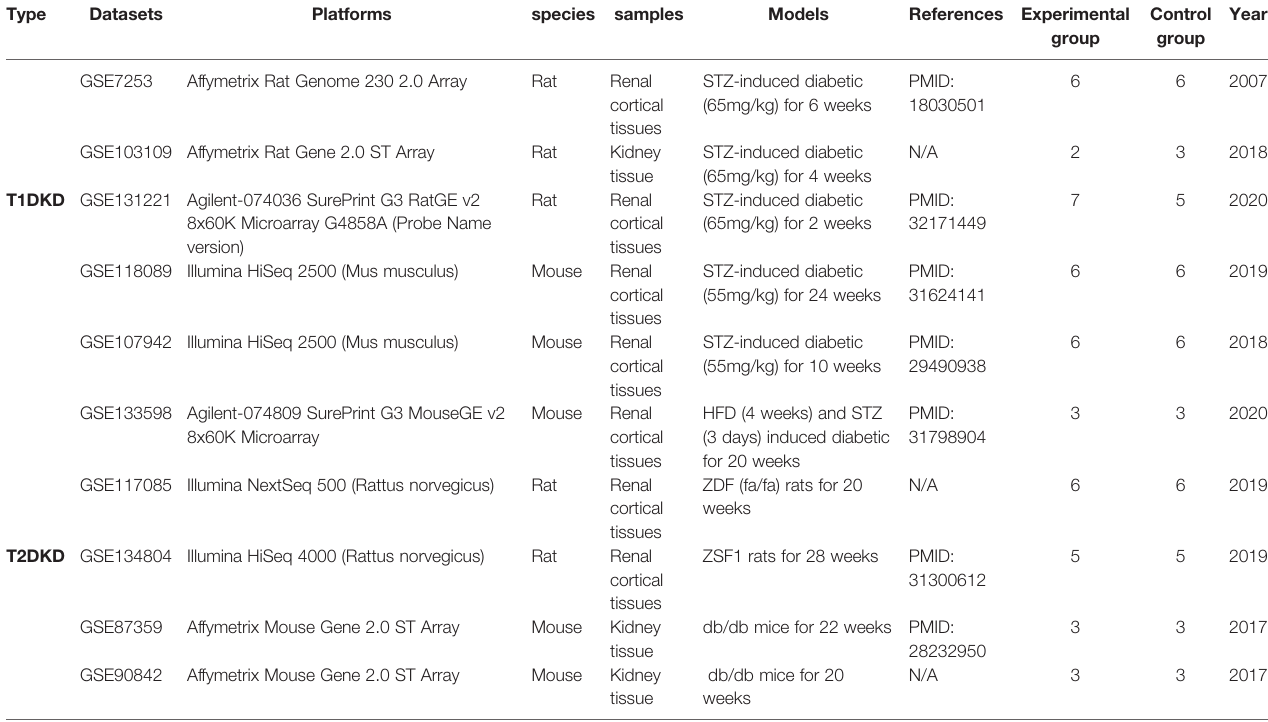
TABLE 1 | The detailed information of datasets used in